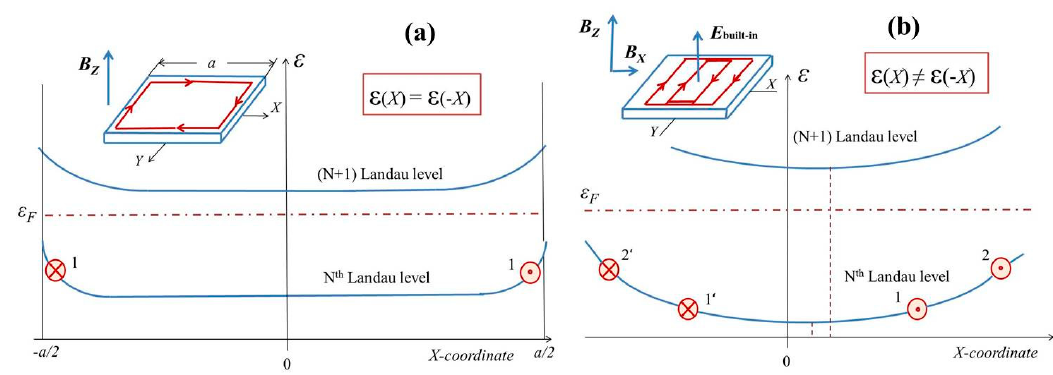
Figure 1. Macroscopic orbit-like quantum states in IQH-type systems. ( a ) Energy spectrum of conventional (symmetric) IQH system. Landau level degeneracy is lifted near the sample edges ( a —the sample length) due to the presence of an electric field pointed toward the sample center. In a combination with the external perpendicular magnetic field, it gives rise to spatially-separated orbit-like quantum states. One of these states is shown schematically in the figure. In this state, electron behaves as a spontaneous current flowing around the macroscopic sample. Dash-dot line denotes the Fermi energy. Inset shows schematically the spatial configuration of macroscopic orbits. ( b ) Estimated energy spectrum of an infinite IQH system with asymmetric confining potential when external magnetic field has both quantizing and in-plane components. Landau level degeneracy is now lifted throughout the whole system due to a combined effect of both “built-in” electric field and in-plane magnetic field. As a result, electrons are in spatially-separated quantum states in which they behave as spontaneous currents flowing in opposite directions along the Y axis. We show two pairs of such currents and in each pair the currents are a counterpart of each other. Spatial asymmetry manifests itself through a microscopic spatial shift of Landau levels, which increases with increasing of the Landau quantum number. Vertical dashed lines show bands’ minima. Inset shows schematically the expected spatial configuration of macro-orbits in a real finite system.